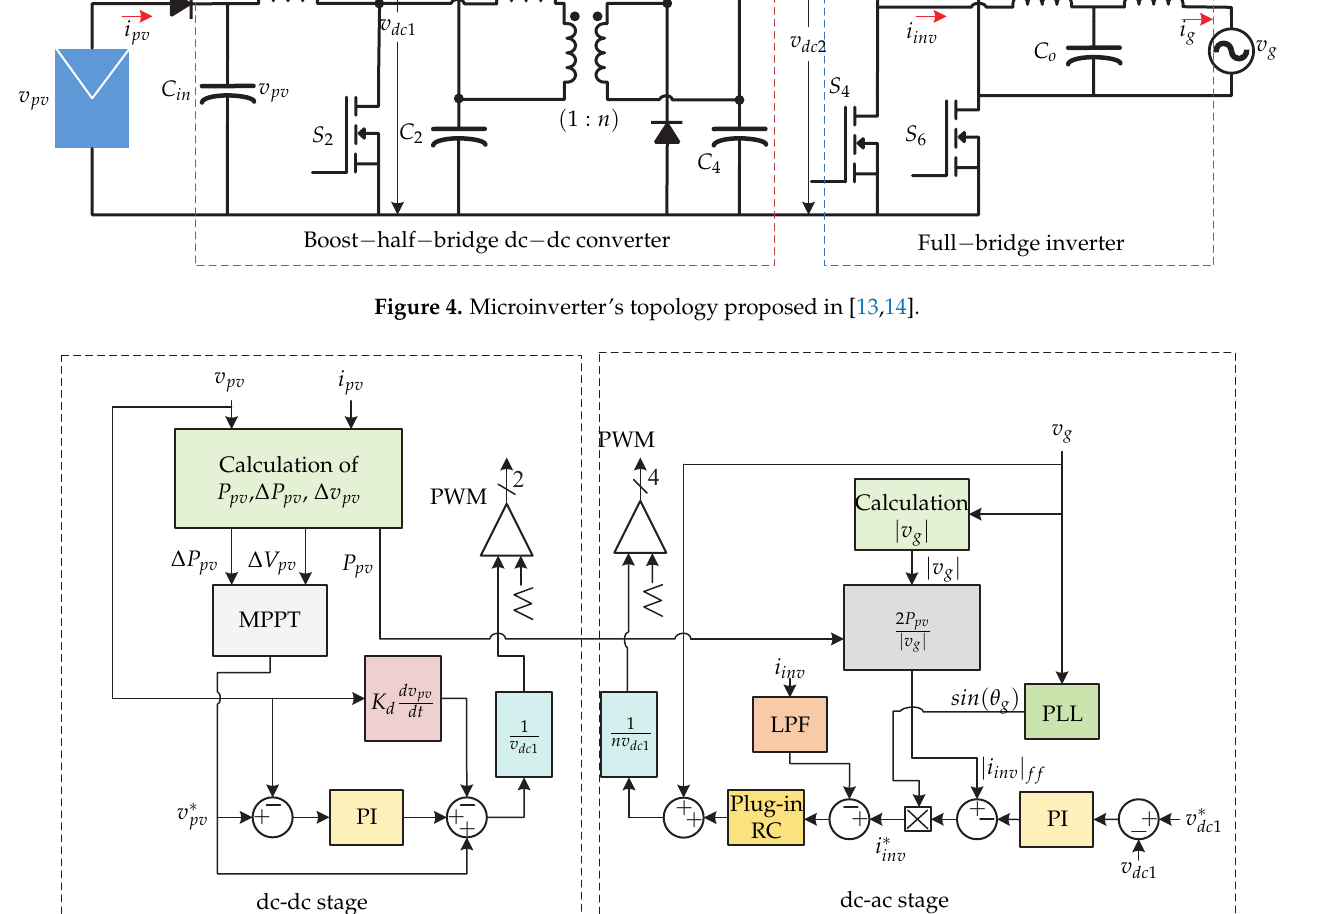
Figure 5. Control strategy proposed in [13,14].